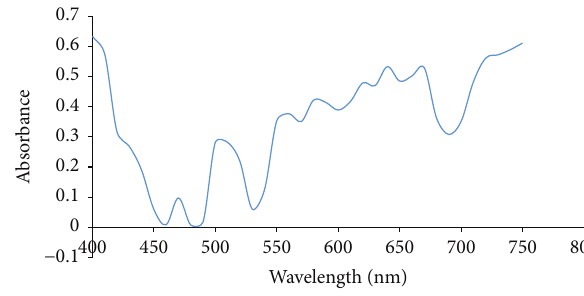
Figure 2: Allamanda methanol extract.